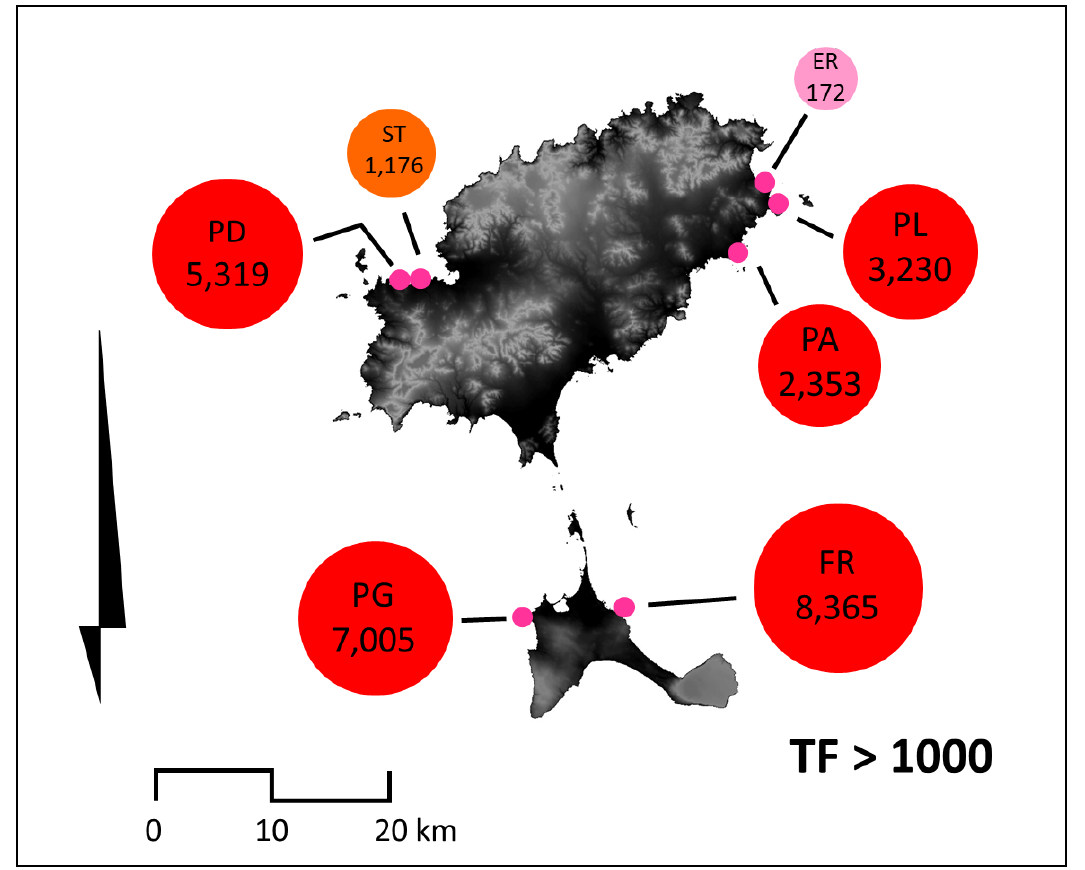
Figure 12. Average values of the Transport Figures for the boulders with TF > 1000. (PD, Punta Pedrera, ST, Sant Antoni, ER, ses Eres Roges, PL, Pou desLleò, PA, Punta Arabí, FT, Punta Prima, PG, Punta Gavina).